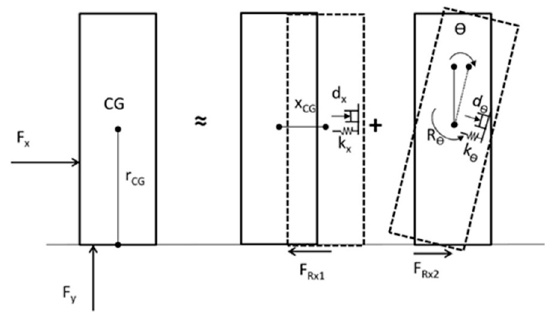
Figure A1. Crown wall movements. Adapted from the system proposed by Pedersen [2].